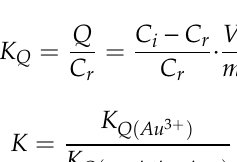
Table 7. The regeneration property of TP-AFC.